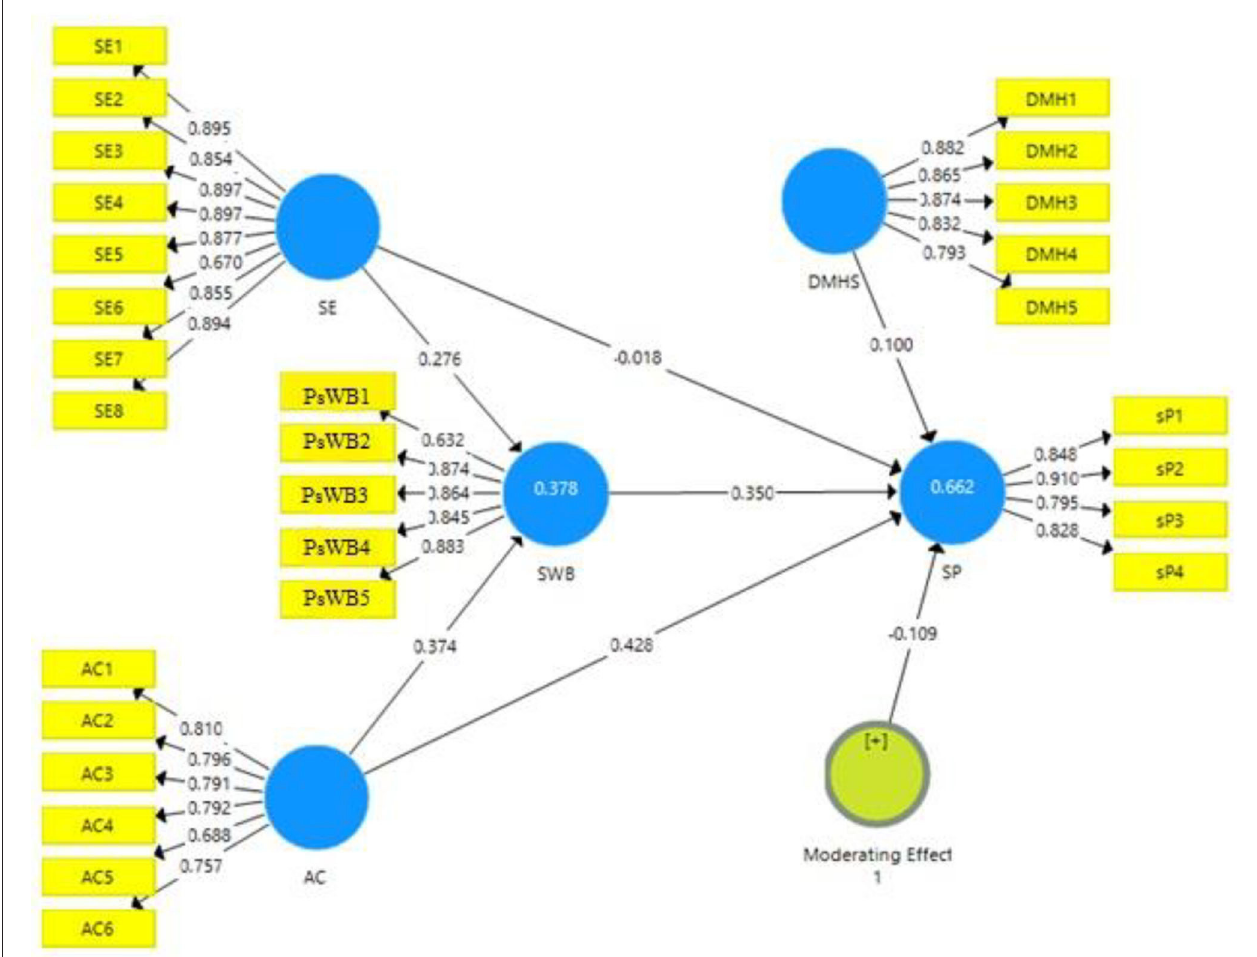
FIGURE 2 | Measurement model. AC, affective commitment; DMHS, digital mental health services; SE, self-efficacy; SP, student performance; PsWB, psychological